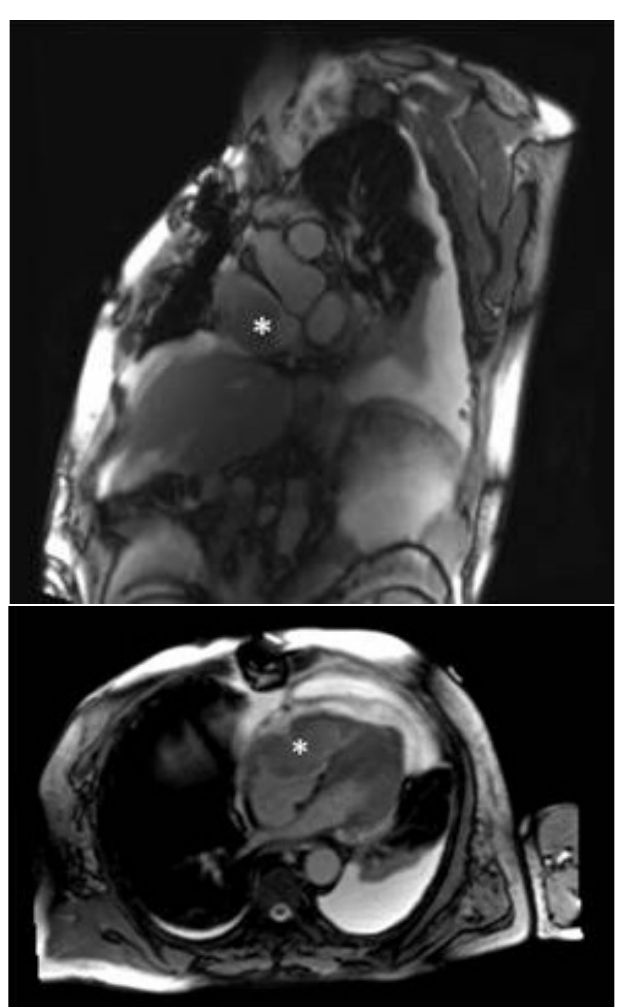
Fig. 3 – Magnetic resonance imaging showing recurred mass in the right atrium. * = Right atrial